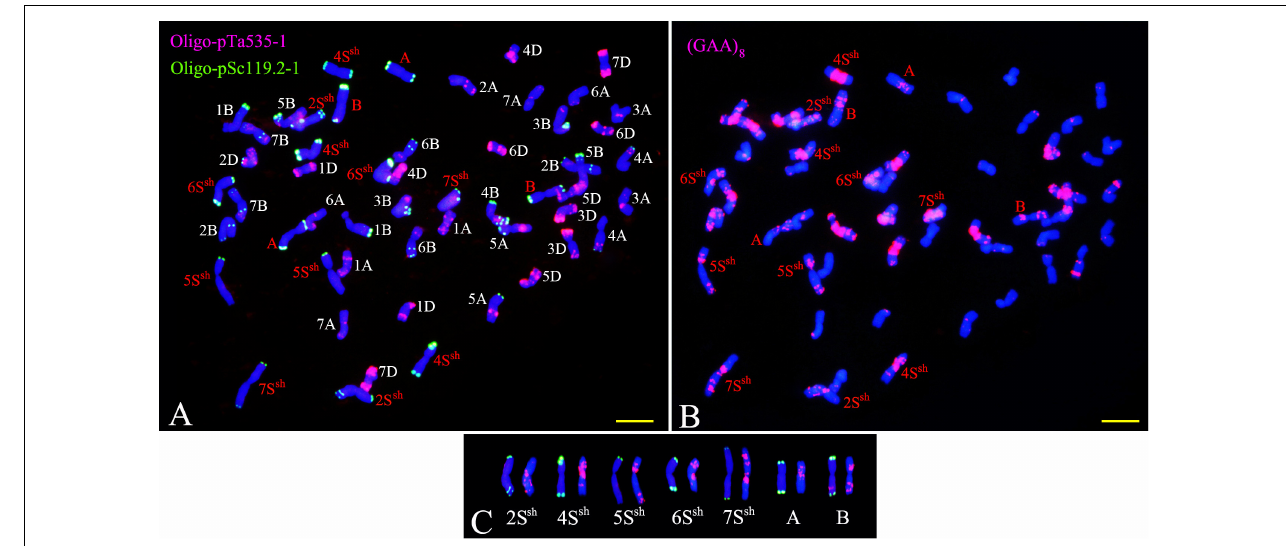
FIGURE 1 | FISH identification of the chromosome constitution of wheat- Aegilops sharonensis amphiploid JIC-31. Panel (A) shows the probes were Oligo-pSc119.2-1 (green) and Oligo-pTa535-1 (red). Panel (B) shows the probe was (GAA) 8 (red). (C) shows the karyotype of the seven pairs of A. sharonensis chromosomes in JIC-31; Panel (A,B) indicates unidentified chromosome. Bar indicates 10 µ m.